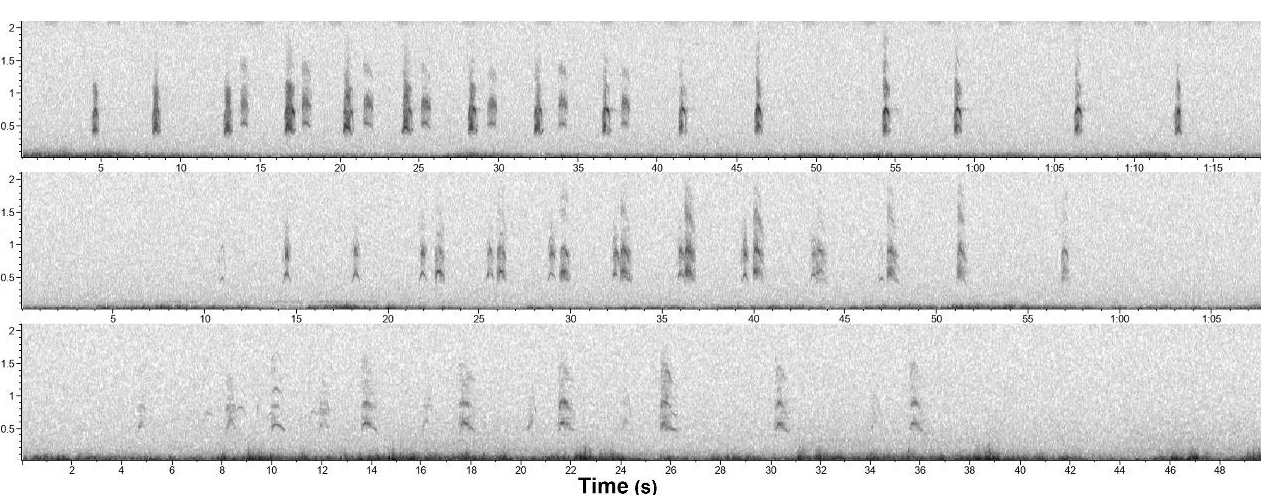
Figure 2. Three examples of maned wolf interactive roar-bark sequences recorded passively at the Serra da Canastra National Park, MG/BR. Each was registered in a different recorder site, on 19 July 2014 at 1:55 a.m., 9 April 2016 at 19:21 p.m., and 14 March 2016 at 20:00 p.m., respectively from top to bottom. The audio files of those examples are in Supplementary Material Audio S1 – S3.